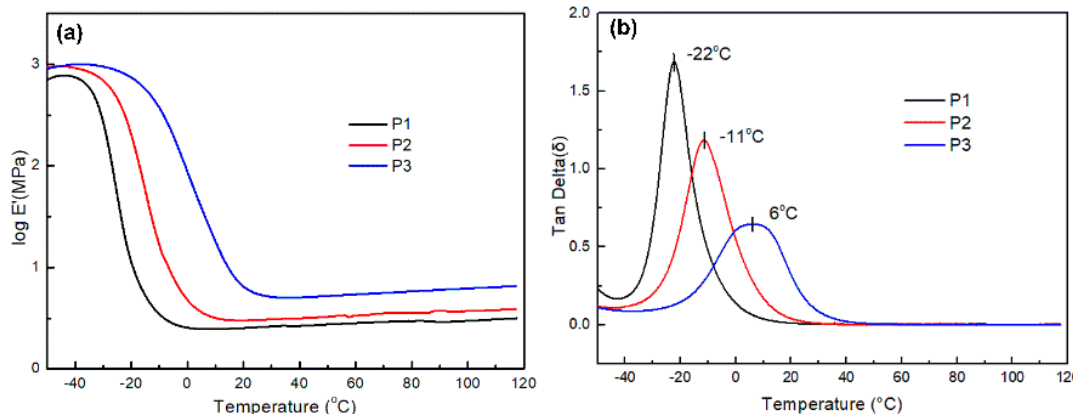
Figure 5. Dynamical mechanical thermal analyzer (DMTA) analysis of the three films: ( a ) storage modulus as a function of temperature of the three films; ( b ) loss factor (tan δ ) as a function of temperature of the three films. Table 4. Dynamical mechanical thermal analyzer (DMTA) data of the three films.